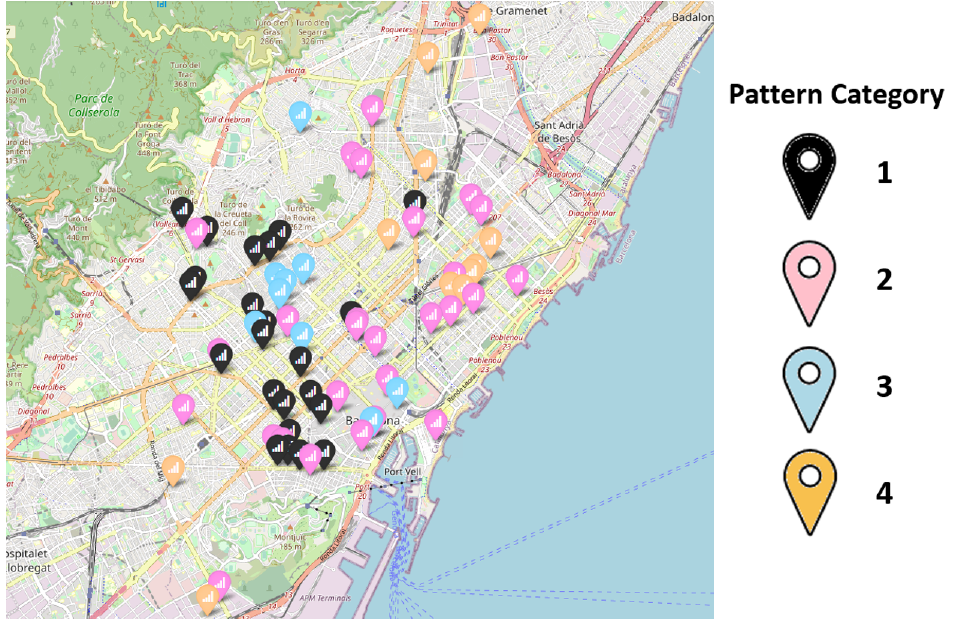
Figure 1. Map showing location and pattern category (indicated by different colors) of the nodes of the WASN of BCN. Category 1 in black, Category 2 in magenta, Category 3 in cyan and Category 4 in brown.